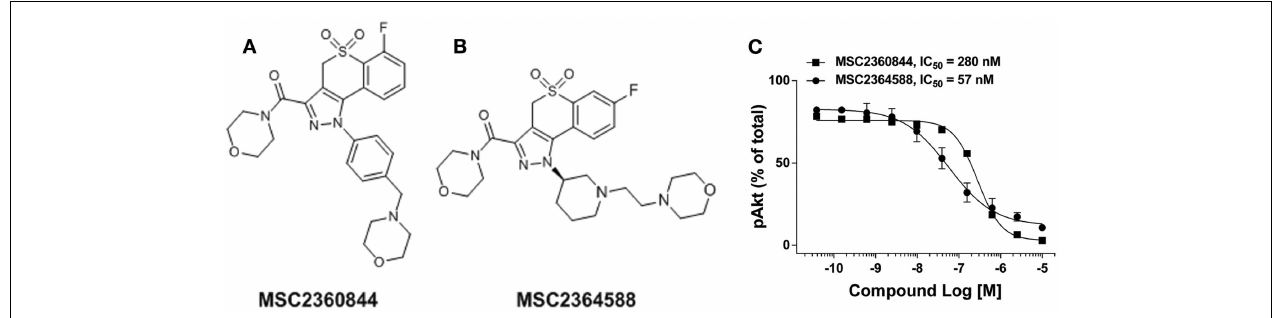
FIGURE 1 | Identification of PI3K δ inhibitor MSC2360844 and MSC2364588 . (A) Chemical structure of MSC2360844. (B) Chemical structure of MSC2364588. (C) Ramos cells were stimulated with anti-IgM for 15min. Intracellular pAkt was measured by flow cytometry. Data shown are mean ± SEM and are representative of three experiments.